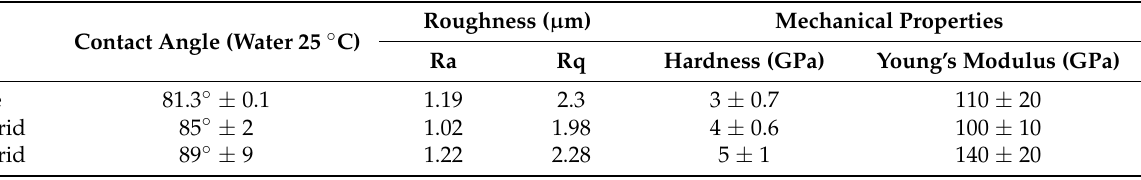
Table 3. Surface and mechanical properties of the uncoated Ti substrate and coated with both